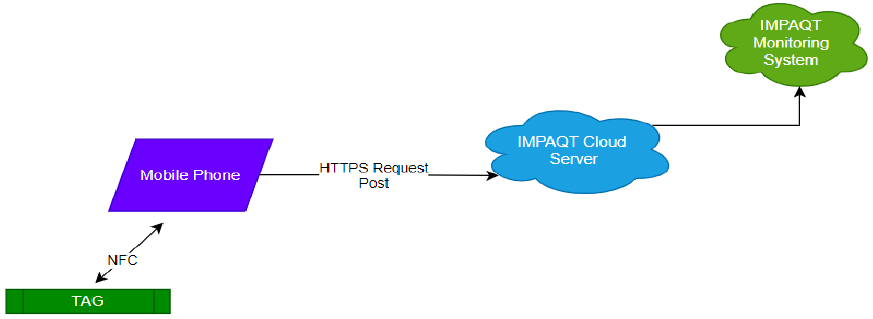
Figure 9. Data upload procedure to the IMS for visualisation.